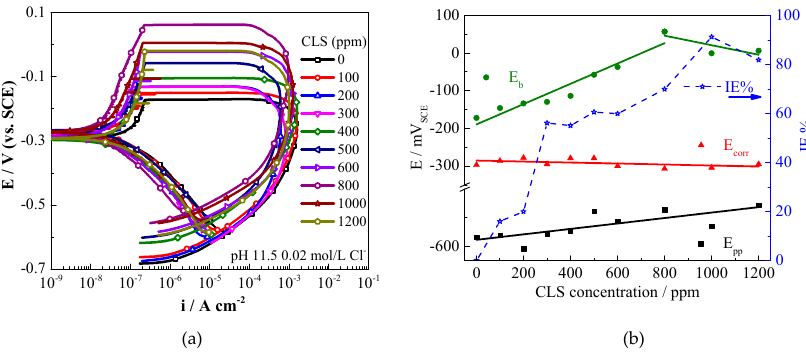
Figure 1. ( a ) Polarization curves of Q235 carbon steel in simulated concrete pore (SCP) solution with various concentration of calcium lignosulfonate (CLS); ( b ) Electrochemical parameters based on the polarization curves.